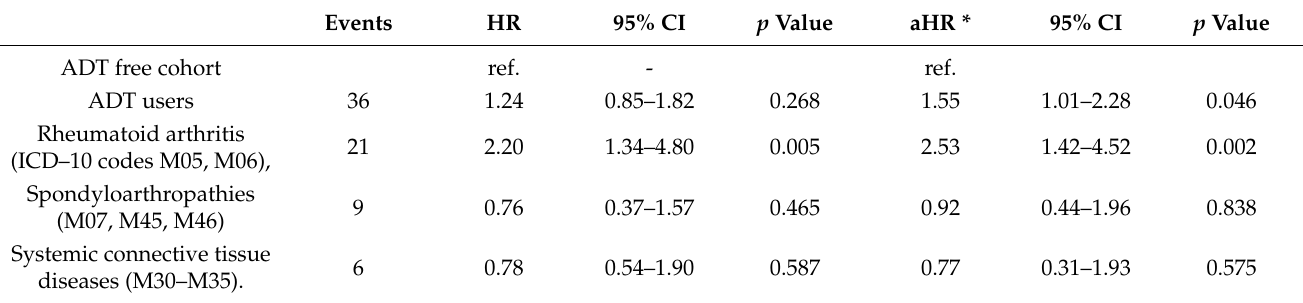
Table 2. Hazard ratios (HR) for RD in prostate cancer patients according to use of ADT and spe- cific